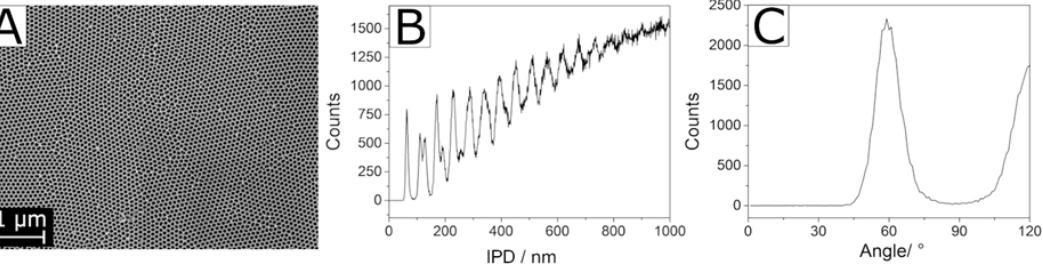
Figure 13. Automatized image analysis of SEM images ( A ) of porous AAO membranes, transformed into α -Al 2 O 3 by Mn-impregnation, with Pore Distribution Function ( B ) and Angle Distribution Function ( C ) [168]. Table 5. Pore diameters of AAO membranes as determined by SEM imaging.